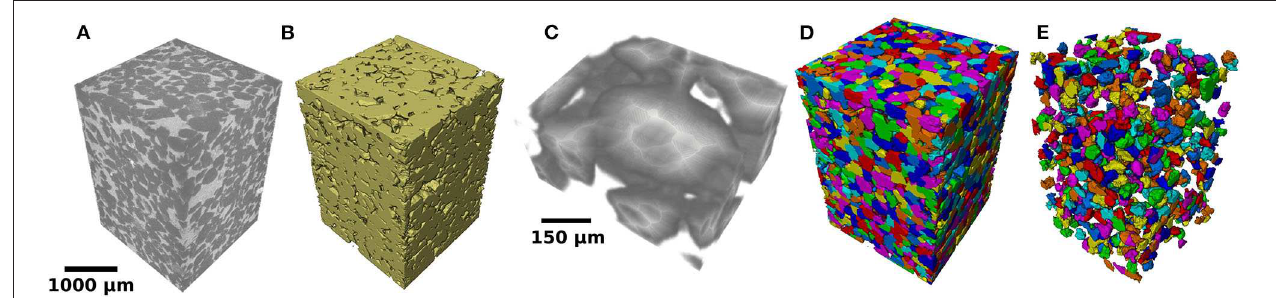
FIGURE 1 | Volume rendering visualization showing (A) the raw 3D data, (B) the segmented quartz grain phase, (C) a sub-volume section showing the distance map used for regional maxima computation for individual grains, (D) the separated quartz grains in the whole volume, and (E) the mean grain size ± 10 % for sample